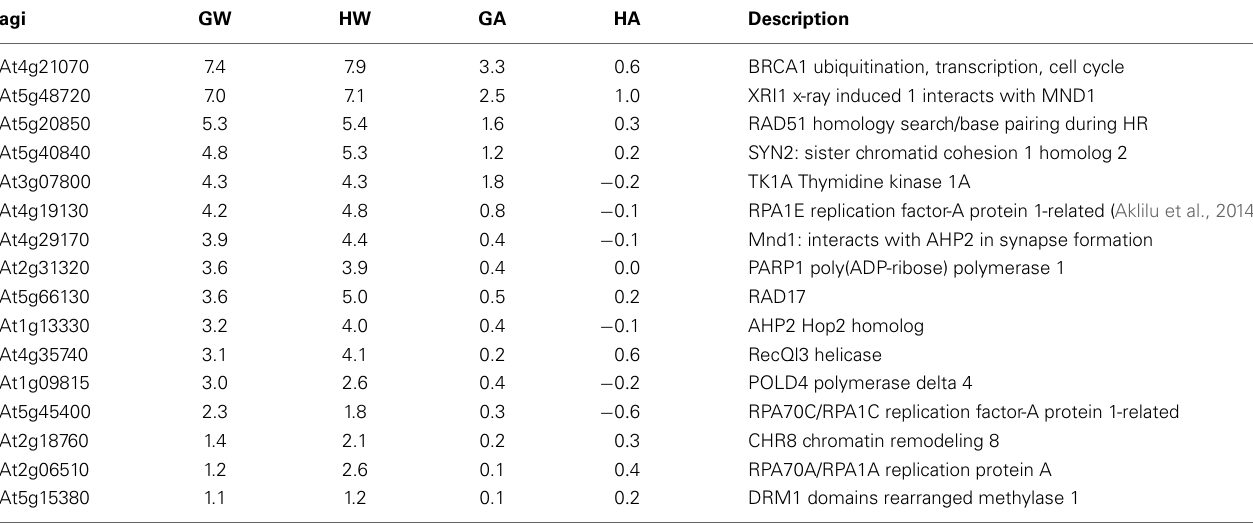
Table 1 | Gamma radiation and HZE share an overrepresentation of DNA metabolic transcripts at 1.5h after IR. agi GW HW GA